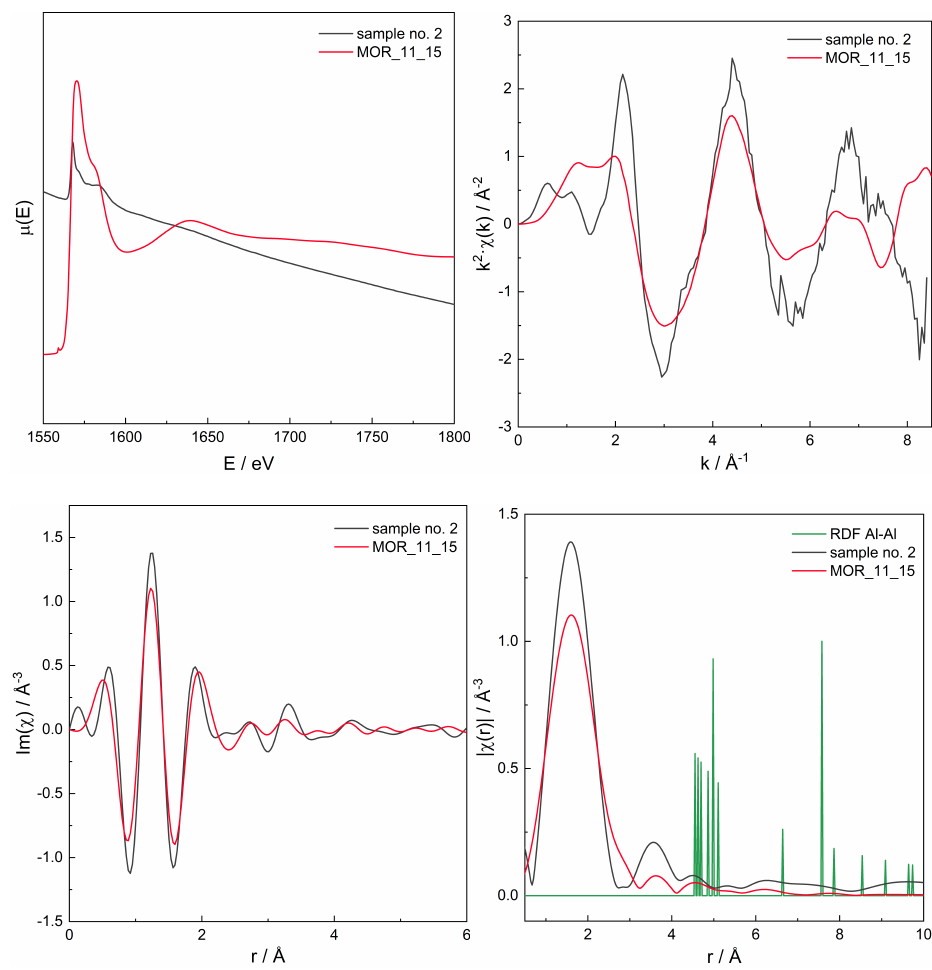
Figure 7. Spectrum of µ ( E ) ( upper left panel ), k 2 χ ( k ) ( upper right ), (cid:61) χ ( r ) ( lower left ), and | χ ( r ) | ( lower right ) for sample no. 2 (MOR of Si/Al = 10) and simulation for computational model labelled MOR_11_15. Matching RMS = 0.0497. The simulation model characterised by Al–Al distances of: 4.5, 5.0, 7.5, and 9.1 Å.